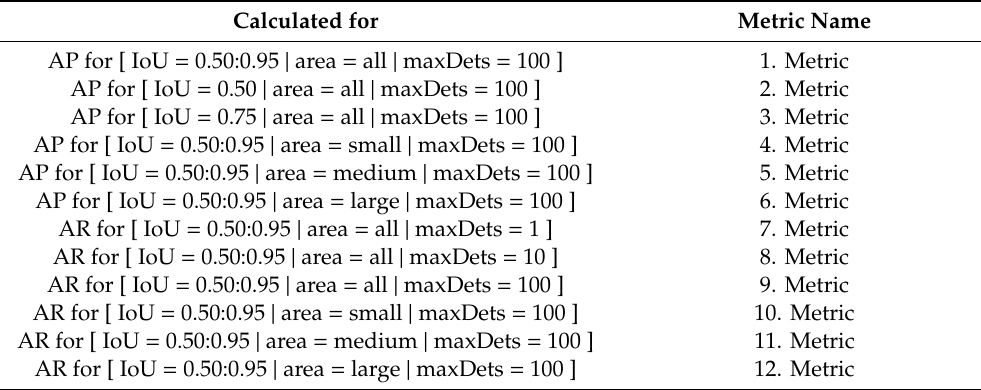
Table 2. COCO performance metrics with calculation rules. Calculated for